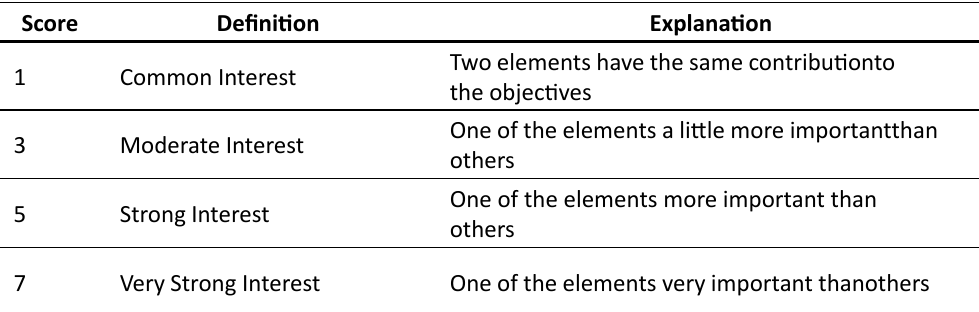
Table 2: Pairwise Comparison